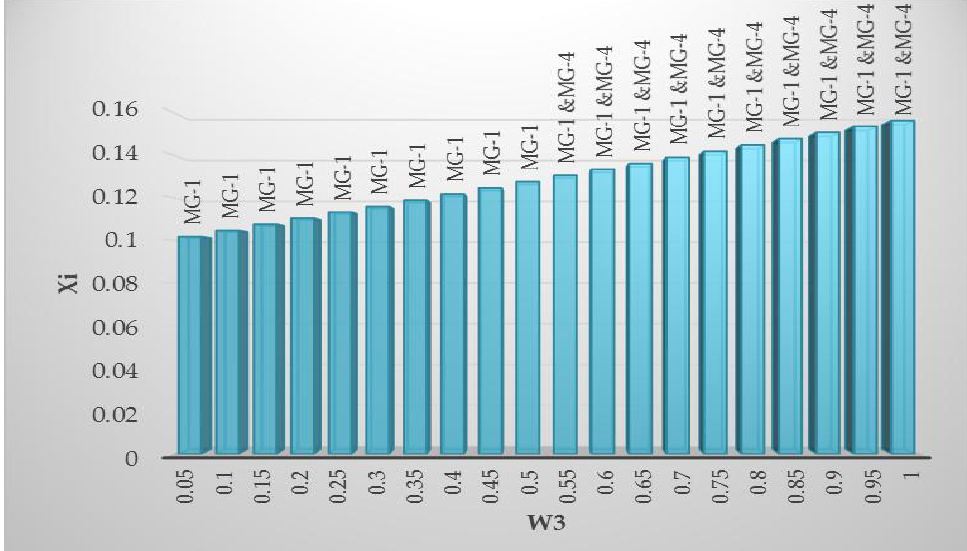
Figure 17. The weighted arithmetic mean ( X i ) depending on the reliability weighted index.